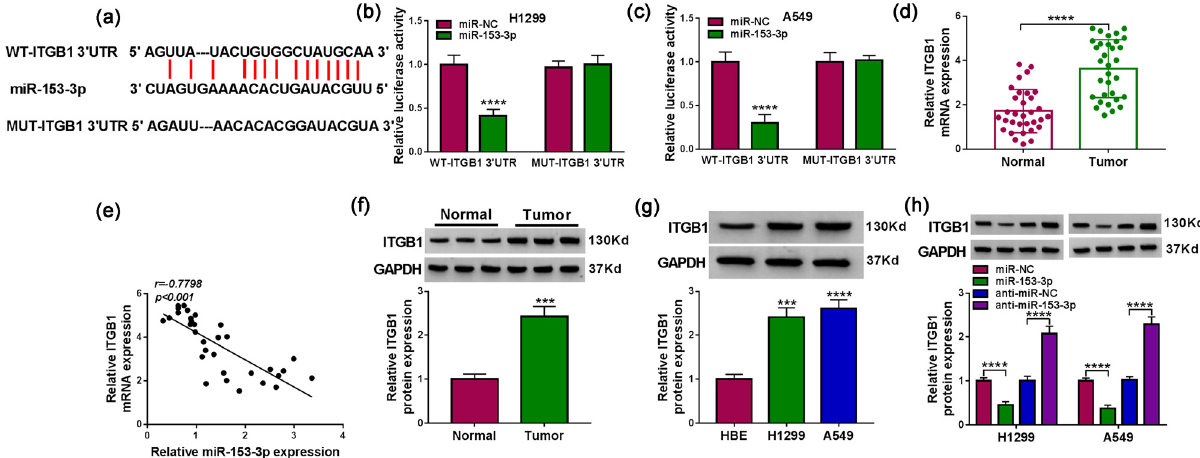
Figure 5: ITGB1 acted as a miR - 153 - 3p target. ( a ) Sequence alignment of wild - type and mutant 3 ′ - UTR of ITGB1 with miR - 153 - 3p. ( b and c ) Luciferase activities of the WT - ITGB1 3 ′ - UTR and MUT - ITGB1 3 ′ - UTR reporters in NSCLC cells with miR - 153 - 3p mimic or miR - NC were determined by dual - luciferase reporter assays ( n = 3 ) . ( d ) RT - qPCR analysis of ITGB1 mRNA in NSCLC tissues ( n = 32 ) . ( e ) Correlation of ITGB1 mRNA and miR - 153 - 3p in NSCLC tissues was analyzed by Pearson ’ s correlation analysis. ( f and g ) Western blotting assessment of the ITGB1 protein level in NSCLC tissues ( n = 32 ) and cells ( n = 3 ) . ( h ) Western blotting analysis of the e ff ects of miR - 153 - 3p inhibitor and mimic on the protein level of ITGB1 ( n = 3 ) . *** P < 0.001 and **** P < 0.0001.